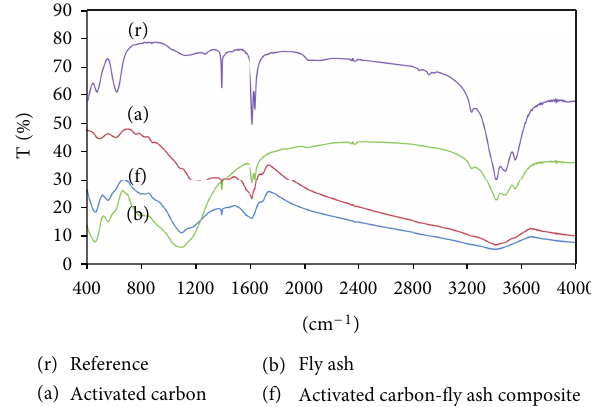
Activated carbon Activated carbon-fly ash composite F 10: F�I� spectrum of precursors and activated carbon-�y ash composite